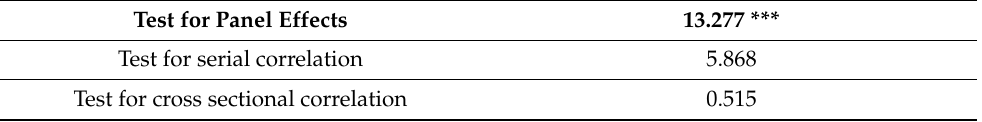
Table 4. Panel causality test and robustness